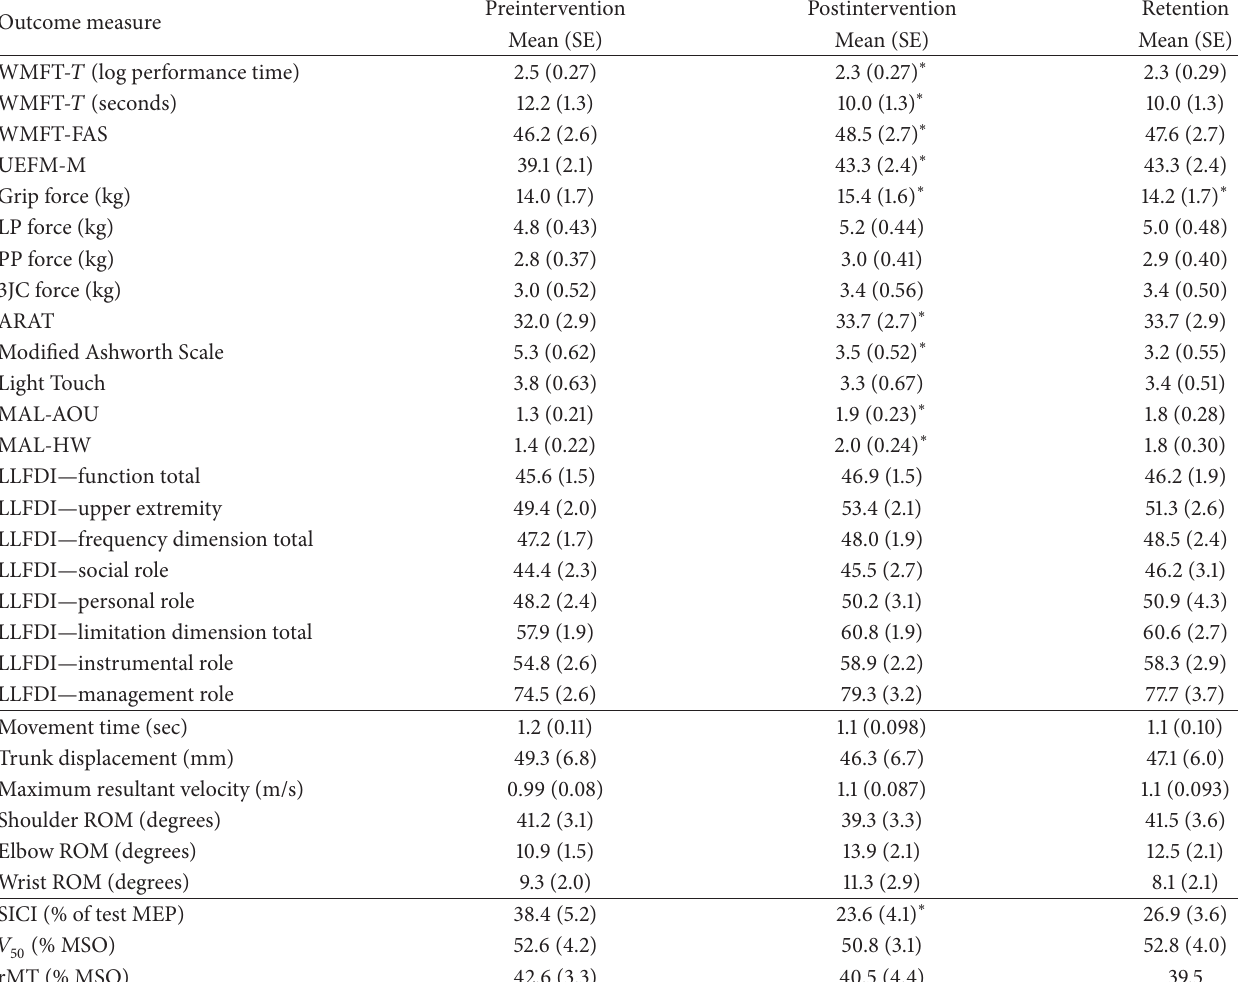
Table 3: Outcome measures for entire cohort ( 𝑛 = 20 ) from preintervention to postintervention and postintervention to retention. Outcome